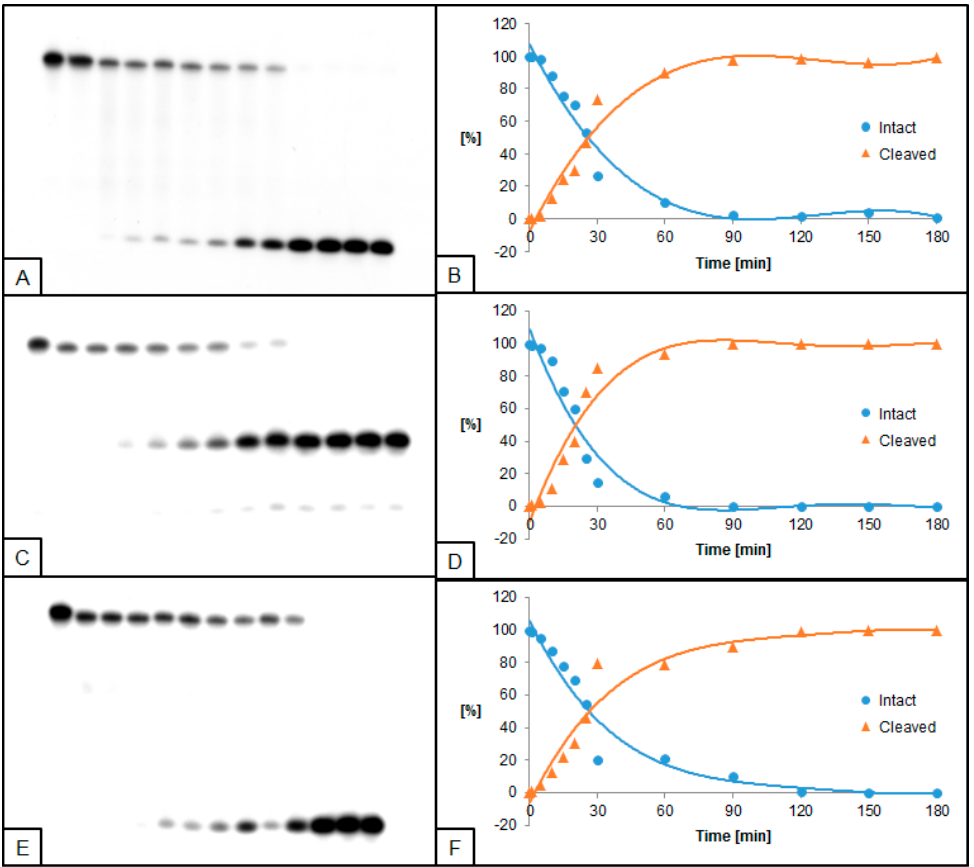
Figure 8. Cleavage of dsDNA containing dU and (5 ′ R ) − 5 ′ ,8-cyclo-2 ′ -deoxyguanosine (RcdG) by 0.5 U UDG and 0.02 U hAPE1. ( A , B ) dU( − 5)RcdG; ( C , D ) dU(+5)RcdG; ( E , F ) dU( − 5)(+5)RcdG. ( A , C , E ) show 13 lanes each, which correspond to reaction times 0, 1, 5, 10, 15, 20, 25, 30, 60, 90, 120, 150, and 180 min starting from the left. ( B , D , F ) show the quantity loss of intact ssDNA (blue) and the quantity increase of SSB-DNA (orange).